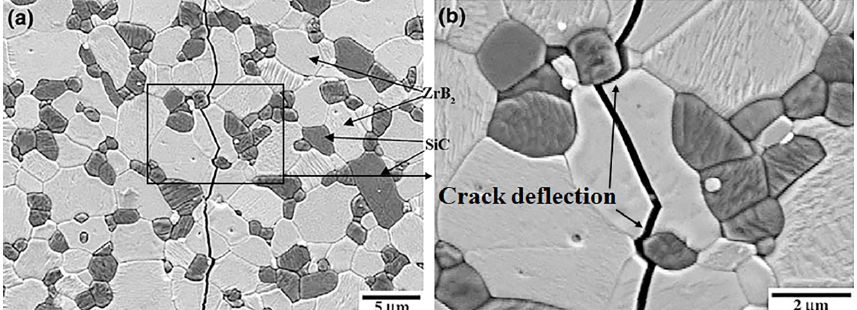
Fig. 7 Typical crack propagation path of ZrB 2 –SiC after indentation at low (a) and high (b) magnification showing crack deflection near SiC particles and predominantly transgranular fracture for ZrB 2 grains. Reproduced with permission from Ref. [148], © Springer Science Business Media, LLC